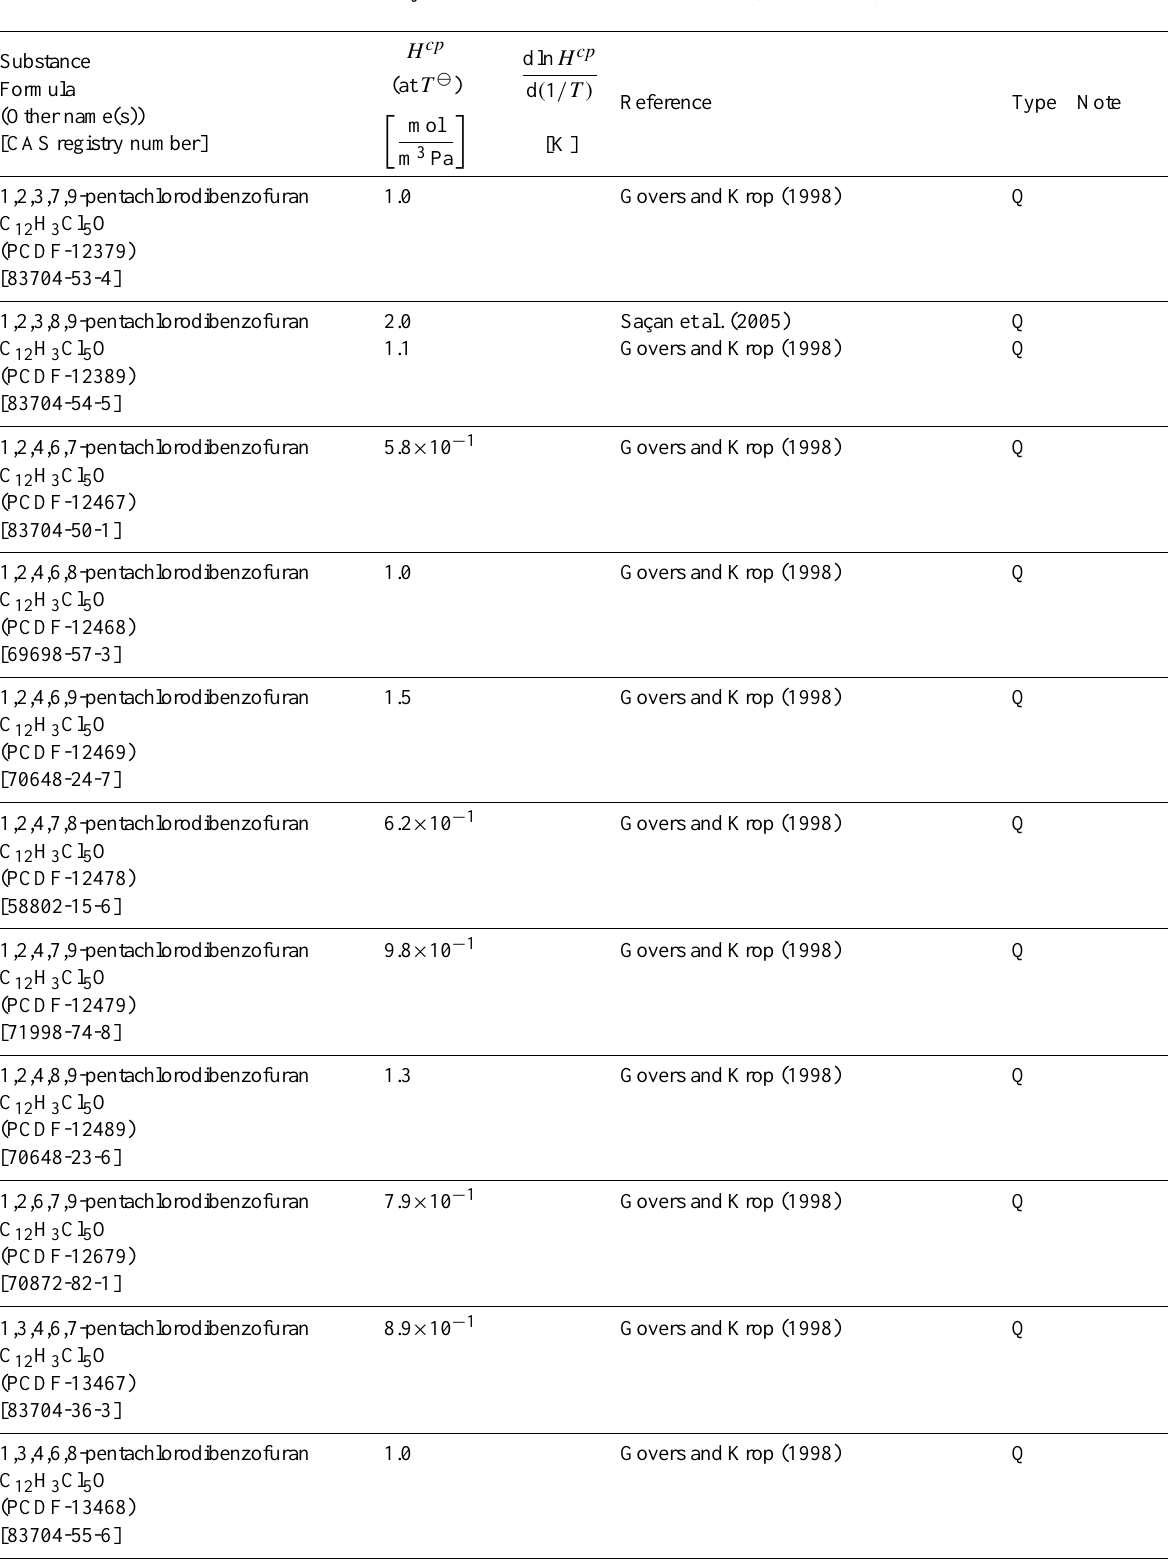
Table 6: Henry’s law constants for water as solvent